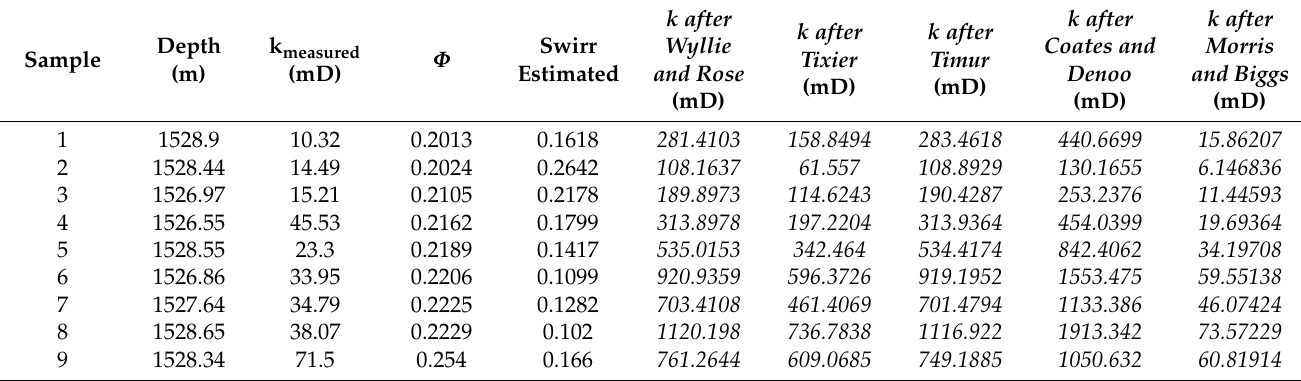
Table 1. Parameters used to develop permeability model C (from [60]) and permeability